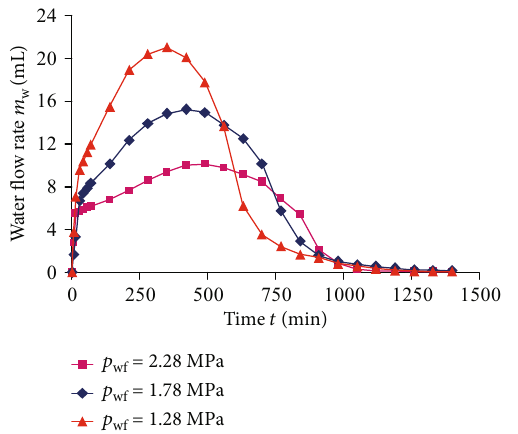
Figure 10: The e ff ect of bottom-hole pressure of the production wellbore on the water fl ow rate in 3-D marine sediments under